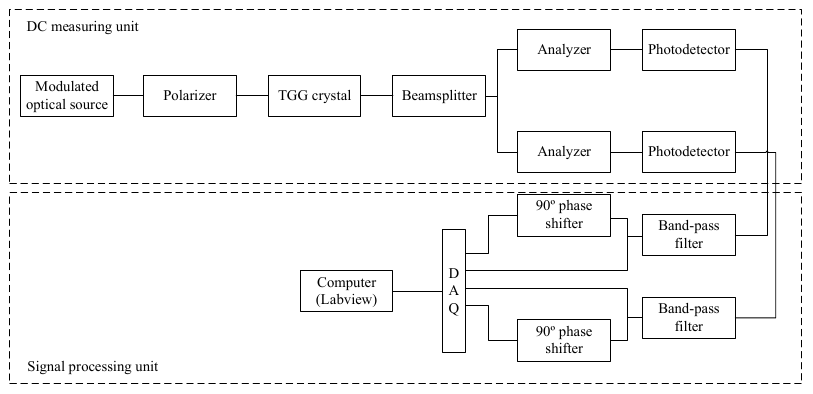
Figure 3. Block diagram of DC measurement system.